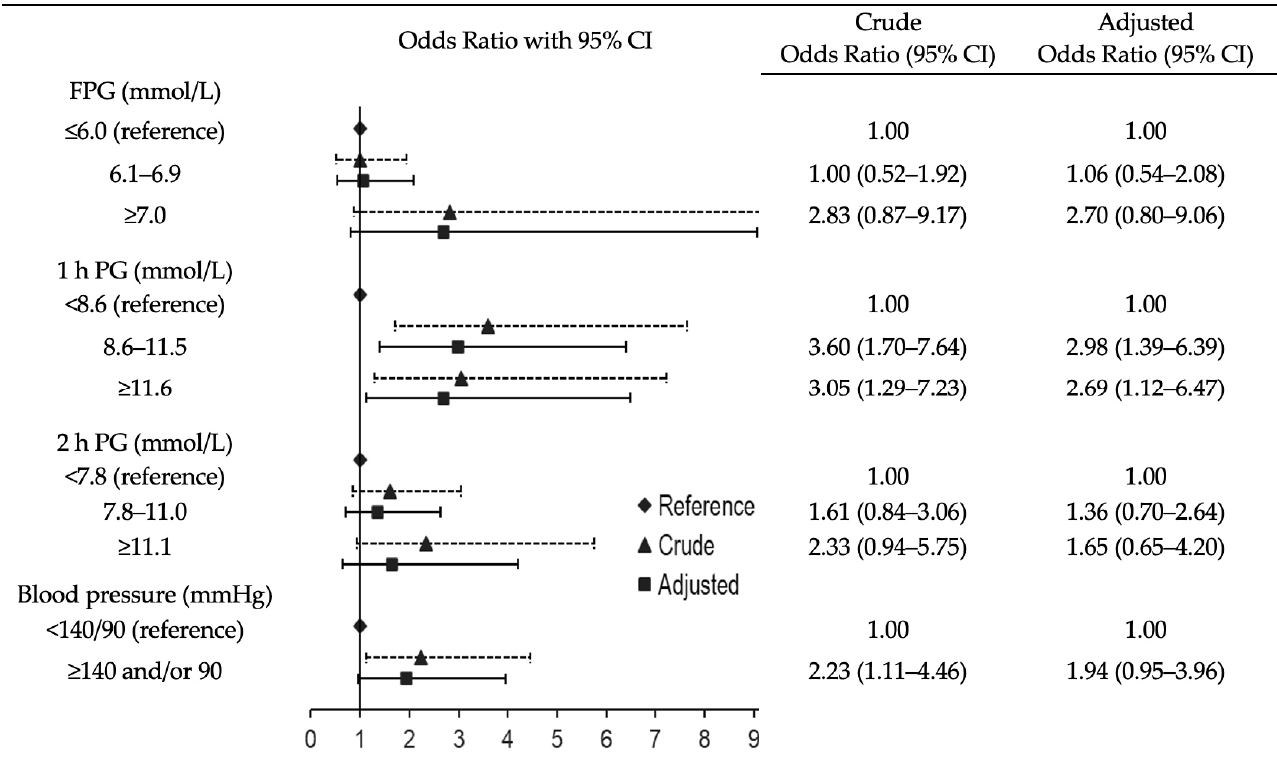
Figure 3. Crude and adjusted odds ratios (95% CI) of albuminuria with fasting plasma glucose, 1 h post-load glucose, 2 h post-load glucose and blood pressure. Dashed line with triangle represents crude values and continuous line with square represents adjusted values. Glucose values were adjusted with blood pressure and age (continuous); blood pressure was adjusted with 1 h post-load glucose and age (continuous).